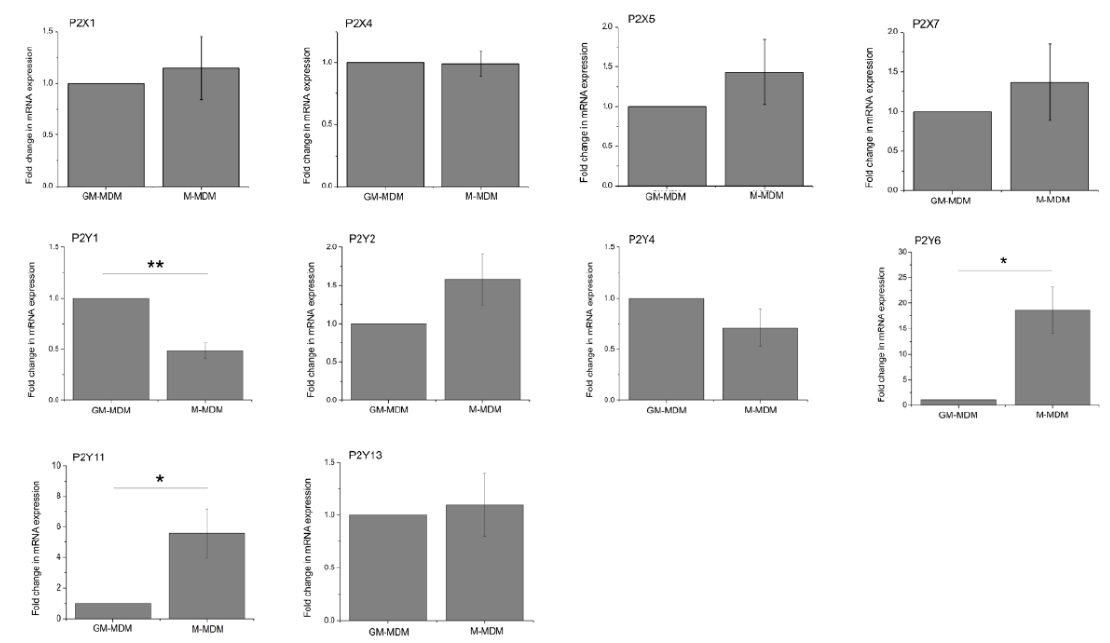
Figure 3. Comparative expression of P2Y and P2X receptor mRNA transcripts in GM-CSF versus M-CSF differentiated human macrophage. Quantitative RT-PCR analysis of mRNA transcripts ( N = 5 donors). Transcript abundance is normalized to a RPLP0 housekeeper gene as an internal control, and each transcript normalized to expression in GM-CSF differentiated macrophage for comparison of fold-change differences in mRNA abundance. * p < 0.05; ** p < 0.01. All data is mean ± SEM; hypothesis testing by t -test.